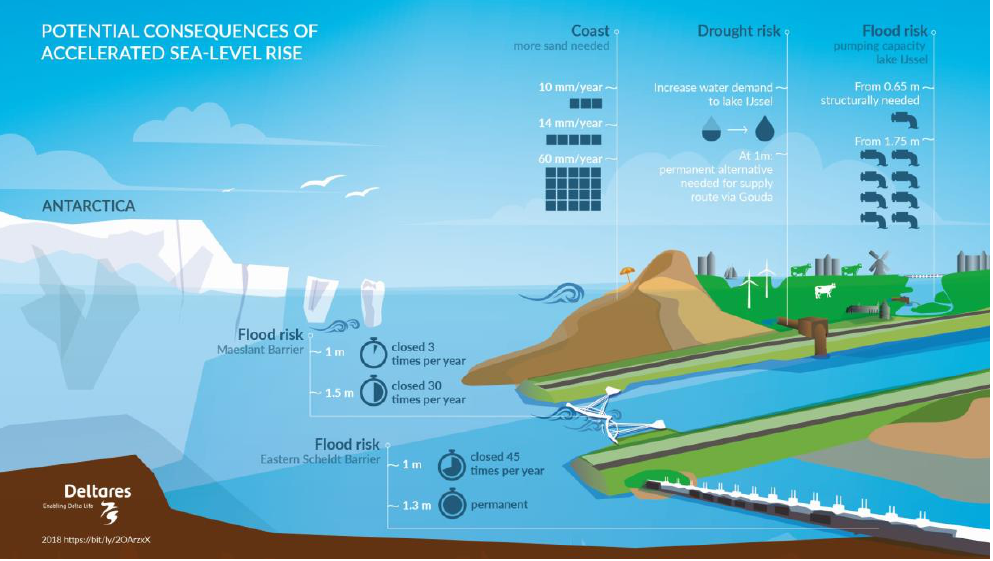
Figure 2. The consequences of accelerated SLR for the main elements of Dutch water